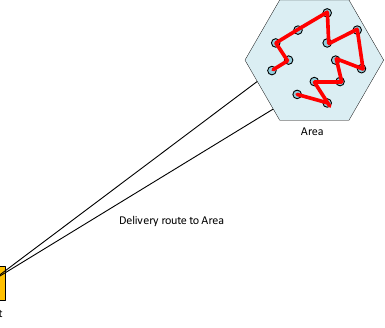
Figure 1. Delivery Route to Area.